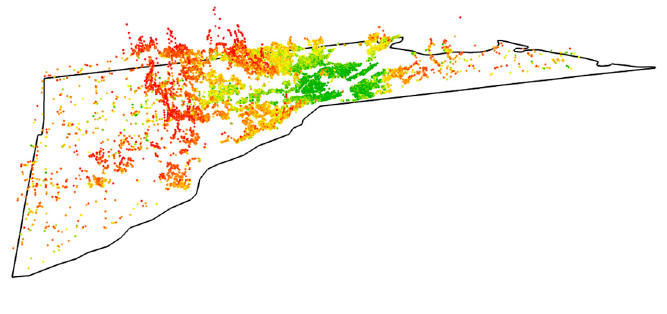
Figure 1. Census tracts and school districts in Lucas County, Ohio.